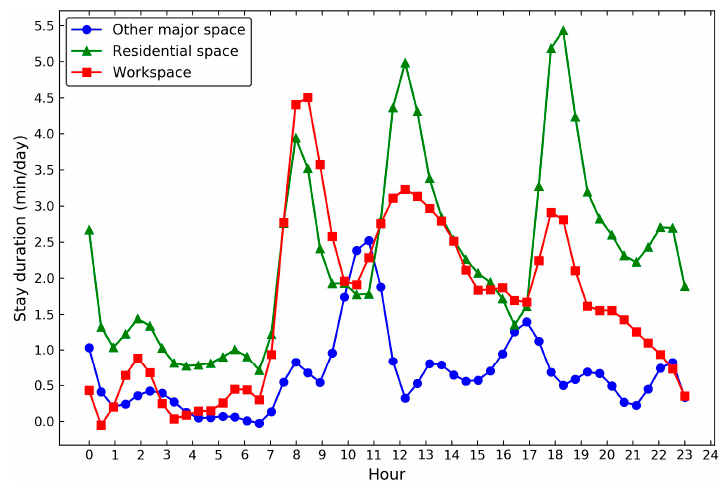
Figure 8. The timing of daily activities and average stay duration in different spaces per day ( n = 107).